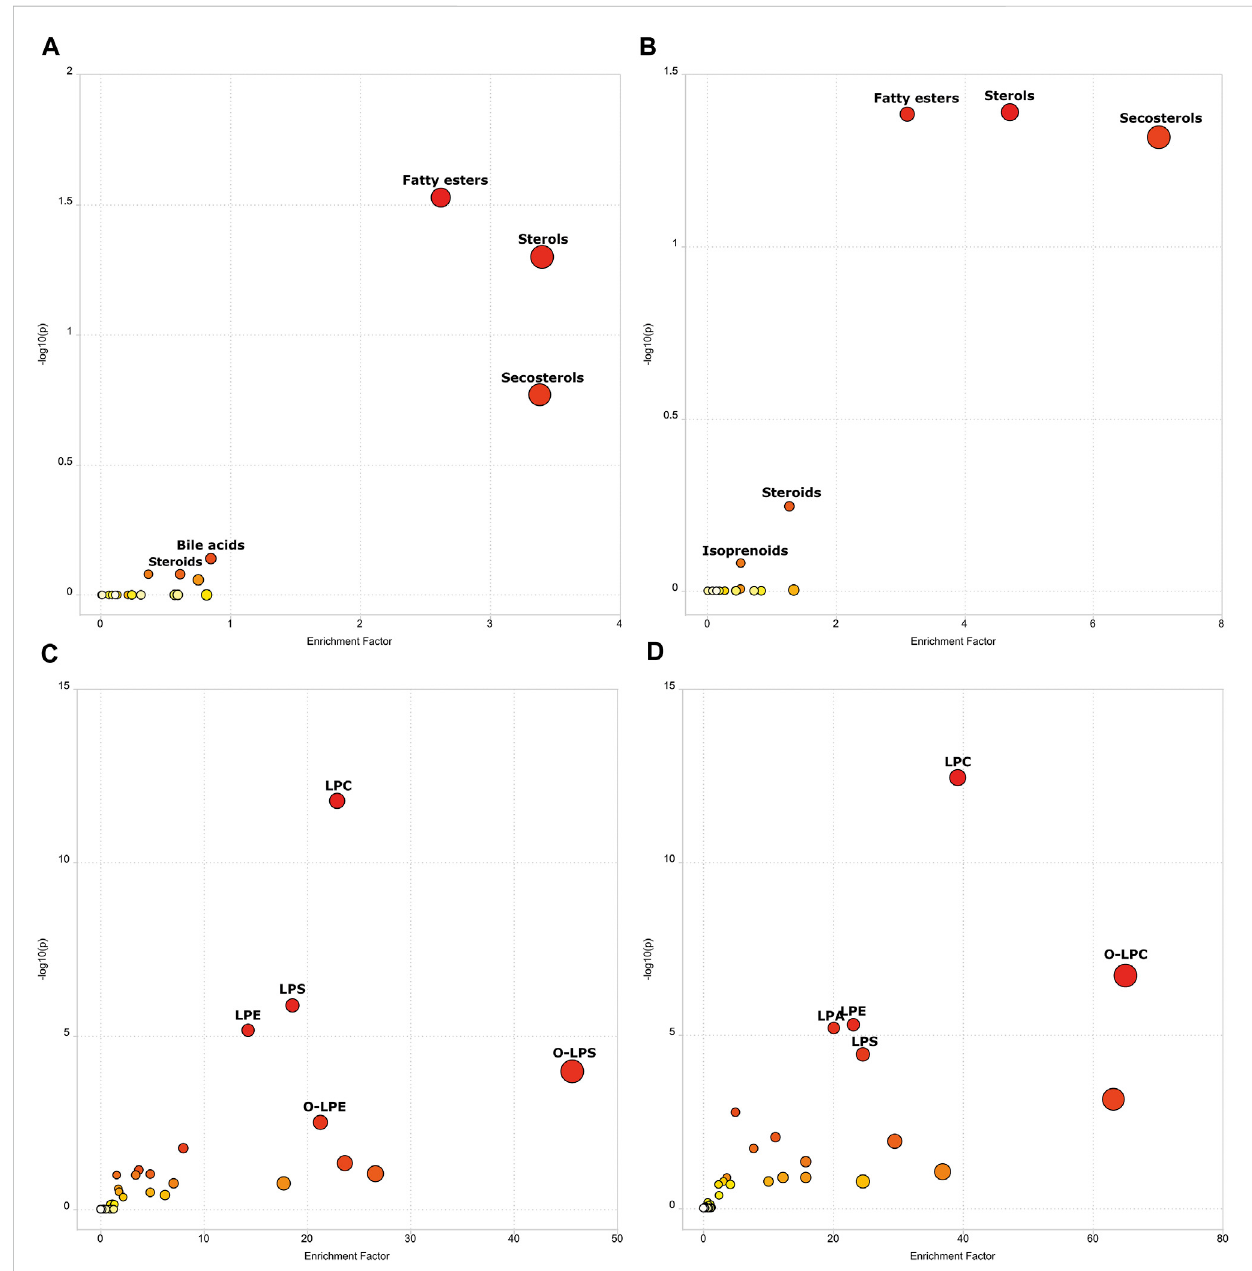
FIGURE 3 Scatter Plot representing Mummichog Pathway Activity Pro fi le showing the enrichment factor. The enrichment factor is the ratio between the number of signi fi cant pathway hits and the expected number of hits within the pathway. (A) Negative controls vs COVID-19 (lipids main chemical class). (B) Negative controls vsPost-COVID-19 (lipidsmain chemicalclass). (C) Negativecontrols vs COVID-19 (lipidssub chemical class). (D) Negative controls vs Post-COVID-19 (lipids sub chemical class). Size and color increases as -log10( p ) and enrichment factor increases. Figure was built